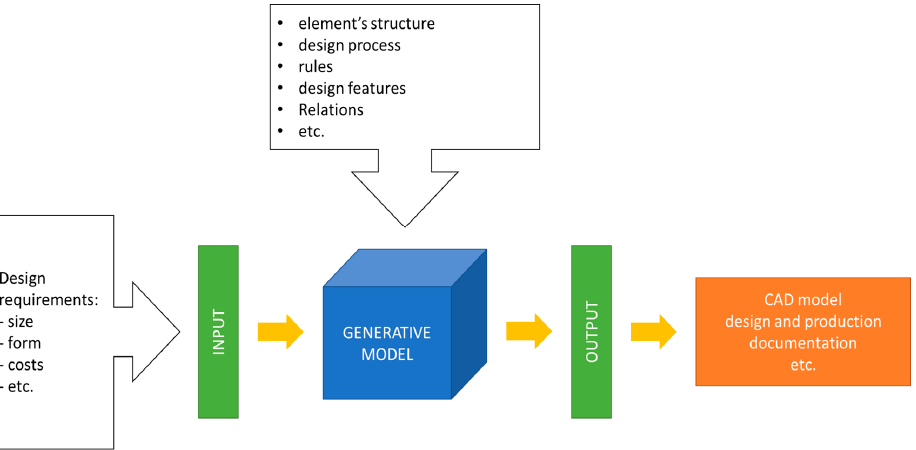
Figure 3. The general schema of the GM functioning [10,15,22].